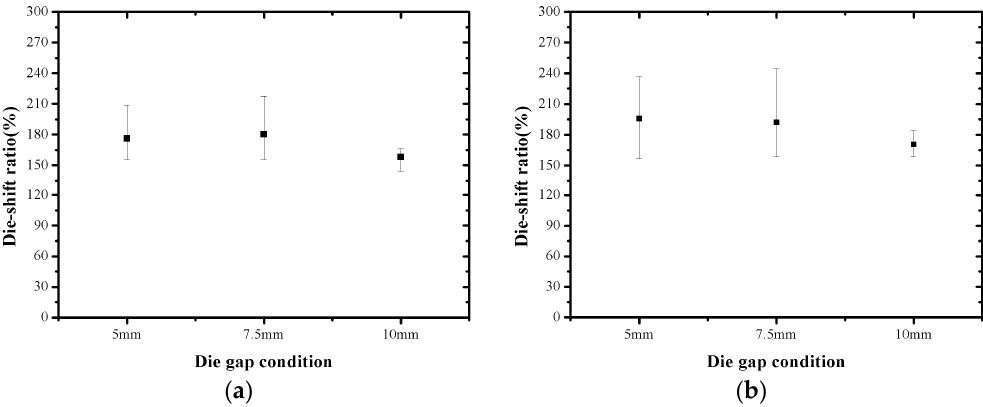
Figure 16. Ratio of die shift caused by flow drag force to that of the debonded wafer: ( a ) 0° direction; ( b ) 90° direction; (die-shift ratio = die shift caused by flow drag force / measured die shift of debonded wafer).